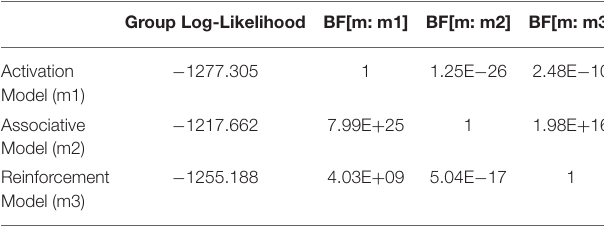
TABLE 5.1 | Summary of log-likelihood and BF statistics for experiment 1.